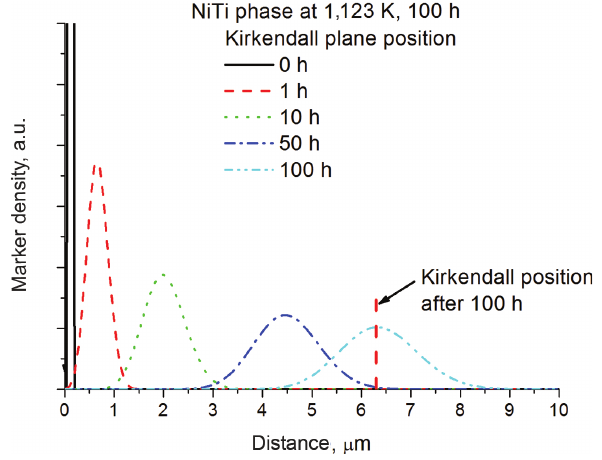
Figure 6: The marker density (Kirkendall plane position) in Ni – Ti intermetallic phase at 1,123 K vs final thickness of the phase.